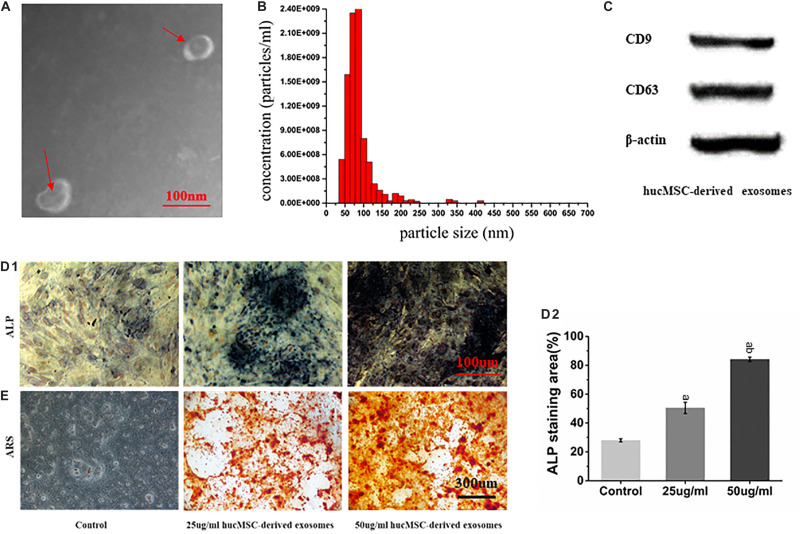
Characterization of hucMSC-derived exosomes. (A) Representative images of the morphology of hucMSC-derived exosomes by transmission electron microscopy. The red arrow indicates exosomes. Scale bar: 100 nm; (B) Particle size distribution of exosomes detected by NanoSight and the mean diameter is 90 nm; (C) Western blot identification of exosomes surface markers; (D1) ALP staining results from stimulation of hucMSC-derived exosomes on mOPCs after 7 days of culture. Scale bar: 100 μm; (D2) Alkaline phosphatase activity (ALP) staining area (%); (E) Alizarin Red Staining (ARS) results from stimulation of hucMSC-derived exosomes on mOPCs after 21 days of culture. Scale bar: 300 μm.